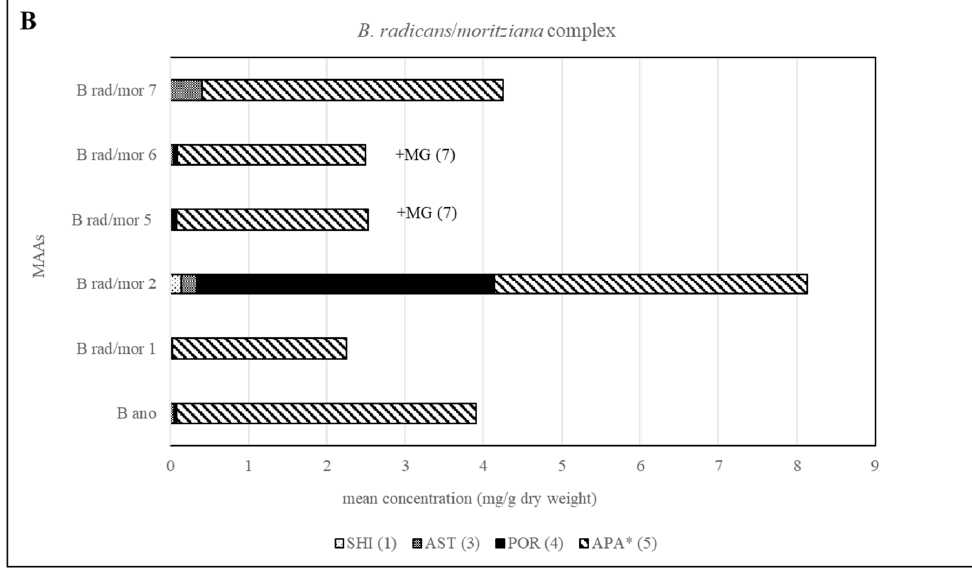
Figure 5. Overview of the content of MAAs expressed as mean value in mg per g of dry material for each lineage of the B. moritziana /B . radicans complex . Assignment of the species: B rad, B . radicans ; B mor, B . moritziana; B ano, B. anomala . * Tentative assignment because palythinol shows identical mass, retention time and UV spectra.